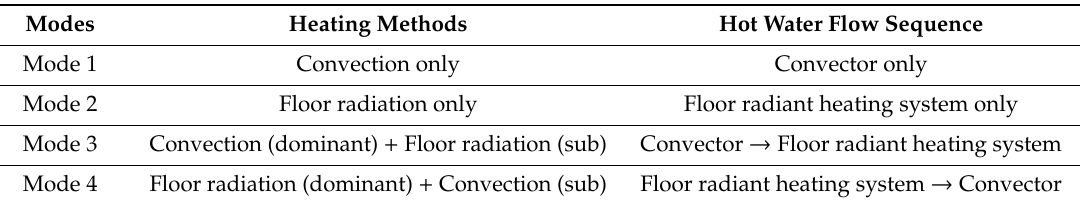
Figure 2. Six-way valve. Table 1. System operation modes.